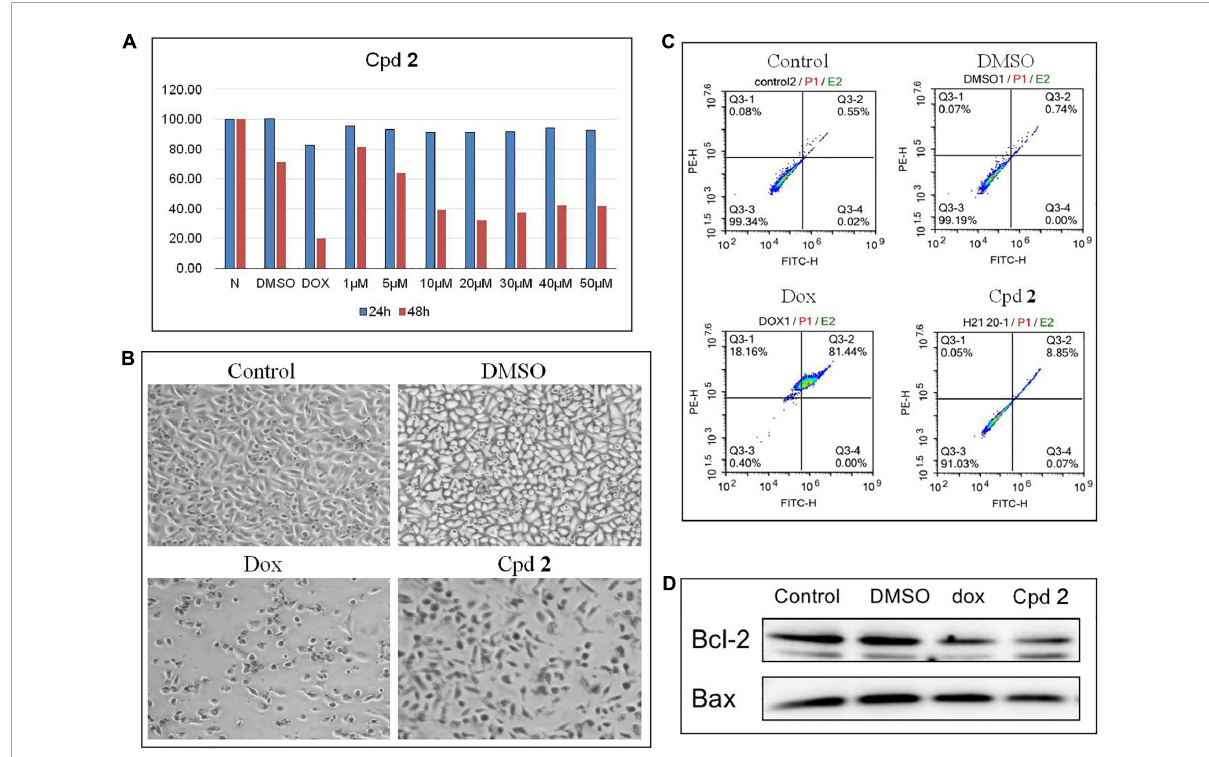
FIGURE4 Compound 2 (Cpd 2 ) induced human pancreatic cancer cells apoptosis. (A) Cytotoxic effect of Cpd 2 on PATU8988T measured by CCK-8. Cells were treated with Cpd 2 at the gradient concentrations from 1 to 50 µ M for 24 and 48 h, respectively. (B) Morphological results of PATU8988T treated with Cpd 2 . (C) Annexin V/PI double staining with flow cytometry analysis was used for the detection of cell apoptosis. (D) Western blotting of Bcl-2 and